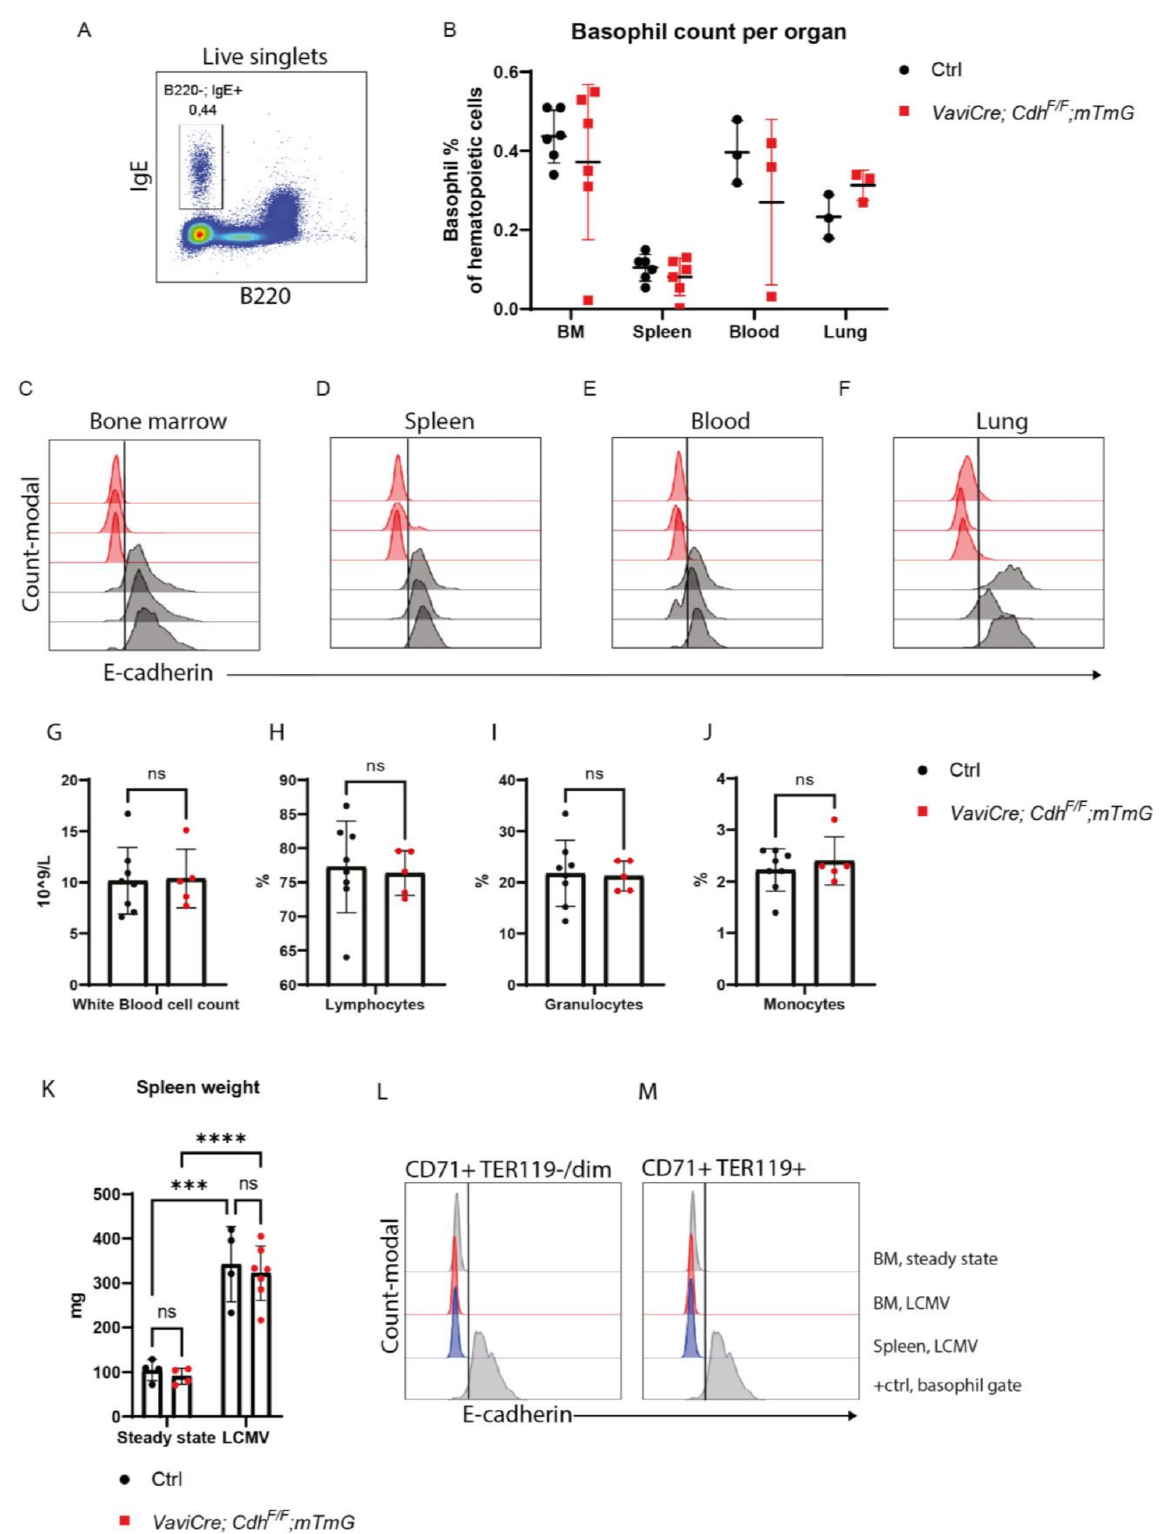
Figure 3. E-cadherin is dispensable for the generation of the basophil and erythroid lineage in mice ( A ) Representative gating strategy of mouse basophil population within live singlets. ( B ) Quantification of the percentage of basophils in hematopoietic cells isolated from VaviCre;mTmG (control; black dotted) and VaviCre;Cdh1 F/F ;mTmG (red dotted) bone marrow (BM) ( n = 6 animals), spleen ( n = 6 animals), blood ( n = 3 animals) and lung ( n = 3 animals) (gating strategy provided